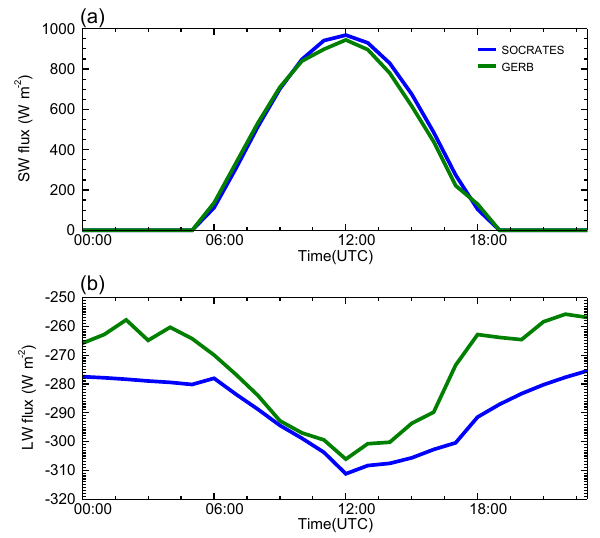
Figure 8. Mean diurnal cycle of TOA flux: (a) shortwave and (b) longwave. SOCRATES results are from the wDwC